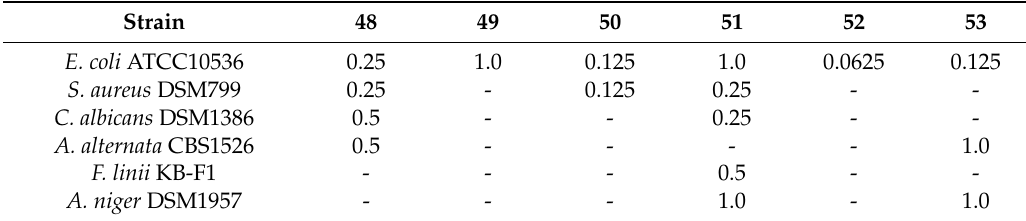
Table 16. Minimal inhibitory concentration (MIC) values (mg/mL) of 48 – 53 against two bacterial DSM1386; and three fungal strains, Alternaria alternata CBS1526, Fusarium linii KB-F1, and Aspergillus niger DSM1957.